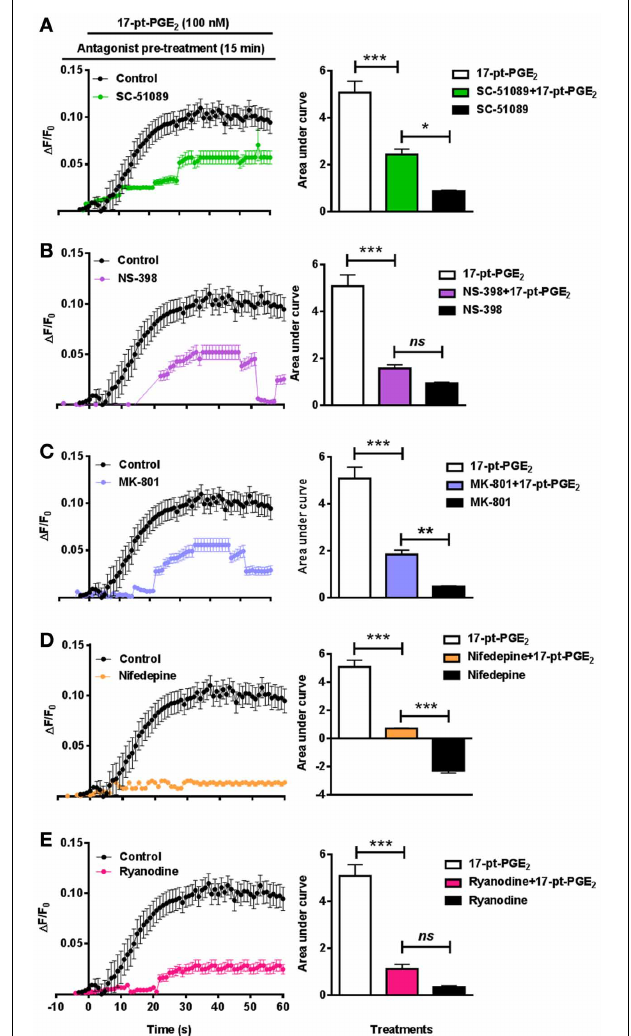
FIGURE 5 | Characterization of EP1 receptor mediated changes in [Ca 2 + ] i in neurons. In a separate set of neuronal cultures, neurons were pre-treated with SC-51089 (10 μ M), NS-398 (10 μ M), MK-801 (10 μ M), nifedepine (10 μ M), ryanodine (50 μ M) or vehicle control before 17-pt-PGE 2 (100nM) application and fluorescence intensity was recorded. Bars above graphs indicate application time of 17-pt-PGE 2 and antagonists/vehicle control. (A–E) (cid:2) F / F 0 and changes in AUC induced by 17-pt-PGE 2 alone and following pre-treatment with (A) SC-51089, (B) NS-398, (C) MK-801, (D) nifedepine, and (E) ryanodine. Data represent mean ± SEM. Statistical analysis was carried out using One-Way ANOVA with Bonferroni’s multiple comparison tests. ∗∗∗ p < 0 . 001 for17-pt-PGE 2 alone or 17-pt-PGE 2 plus antagonist. ∗∗ p < 0 . 01 and ∗ p < 0 . 05 for 17-pt-PGE 2 plus antagonist vs. antagonist alone; ns, not